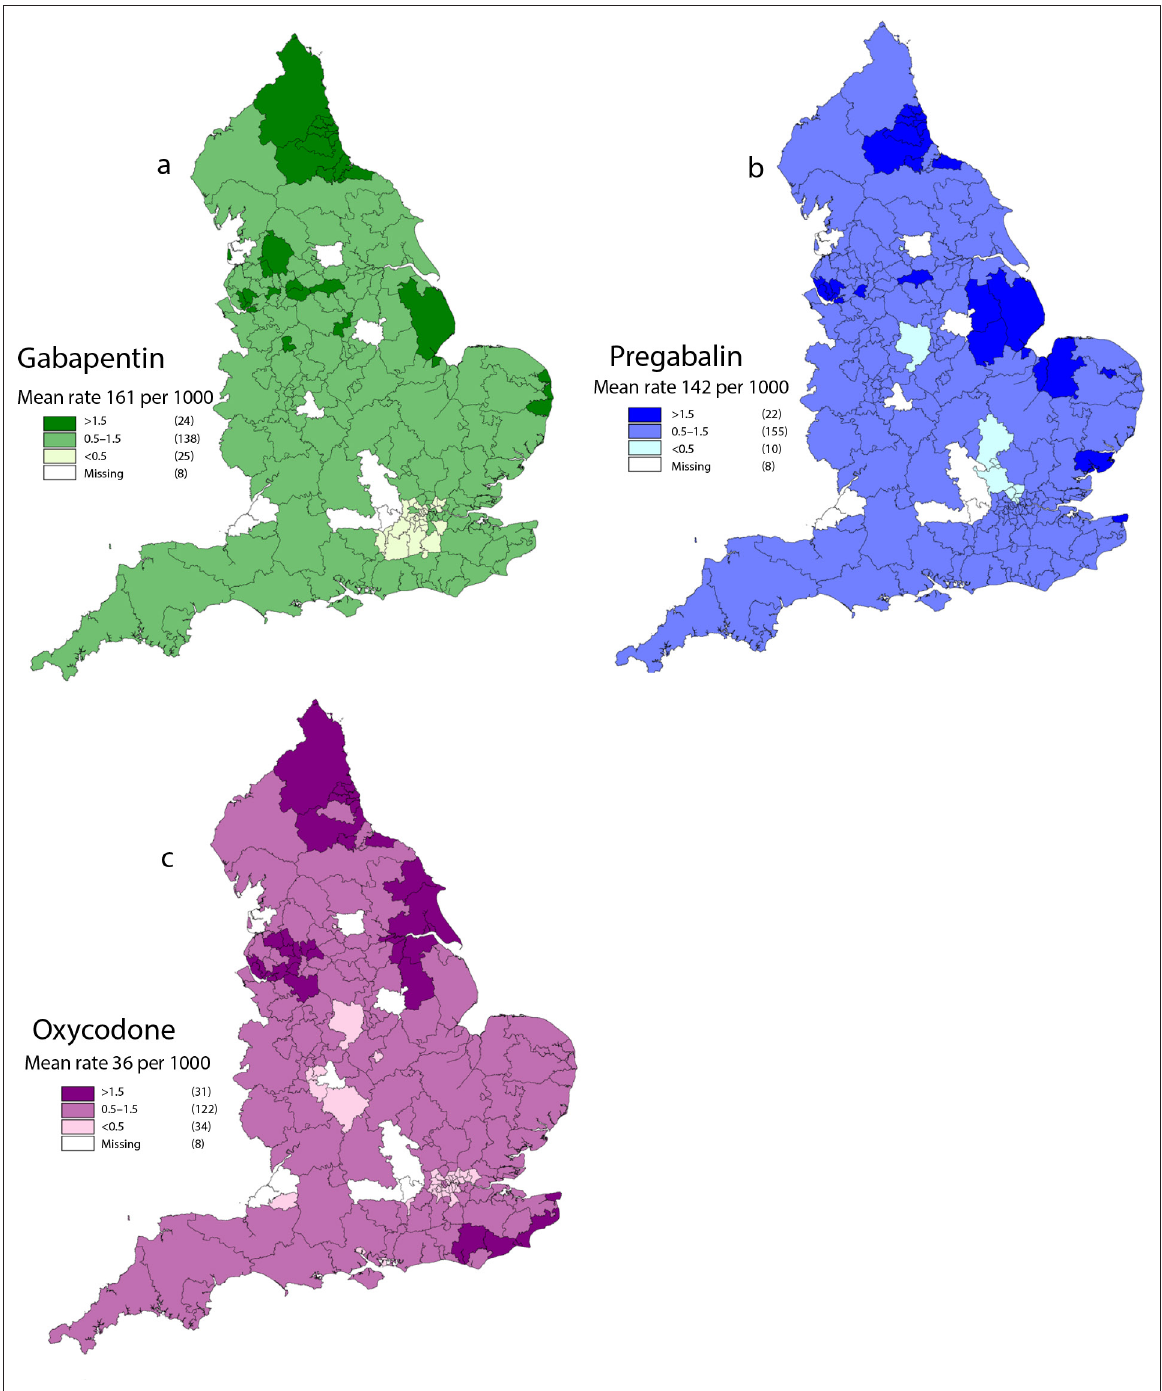
Figure 2 GIS visualisation of CCG’s mean rate of prescribing of a) gabapentin, b) pregabalin, and c) oxycodone. Missing CCGs are given in white and are excluded due to boundary changes or mergers that occurred during the time period of the study ( n = 187). CCG = clinical commissioning group. GIS = geographic information